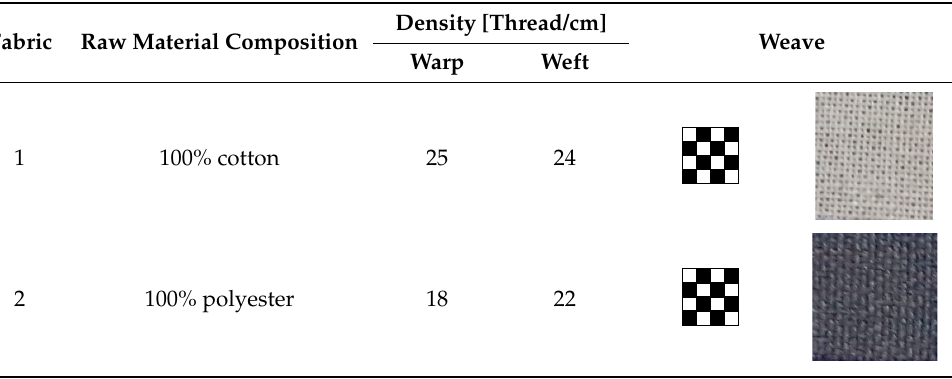
Table 2. Characteristics of textile materials bonded with polylactic acid (PLA) for determining the breaking force.